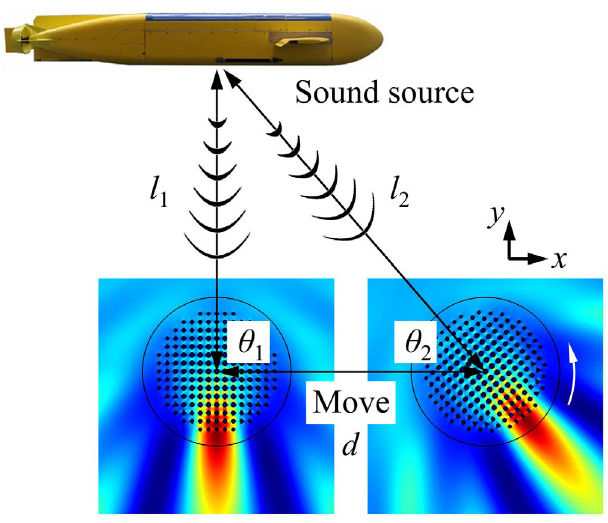
Figure 7. Schematic view of the underwater sound source